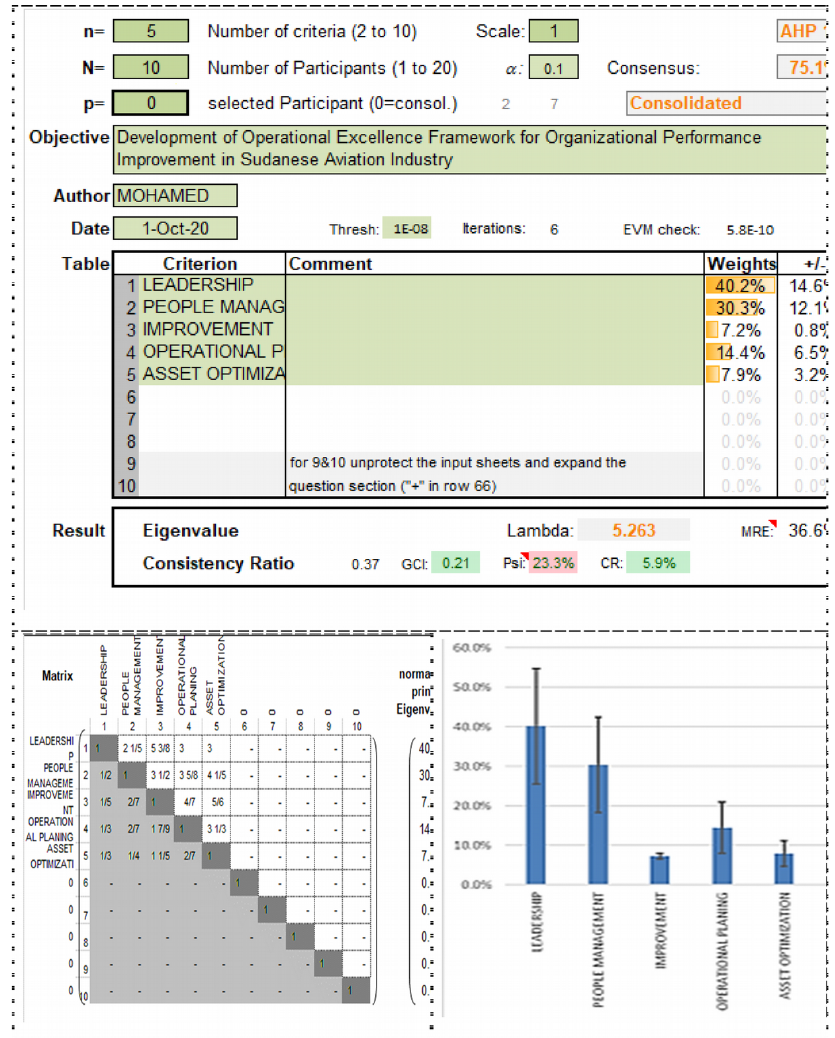
Figure 3. Level 2–Summary of Critical Factors Affecting the Achievement of the OE